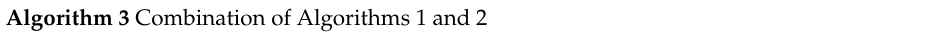
Algorithm 3 Combination of Algorithms 1 and 2